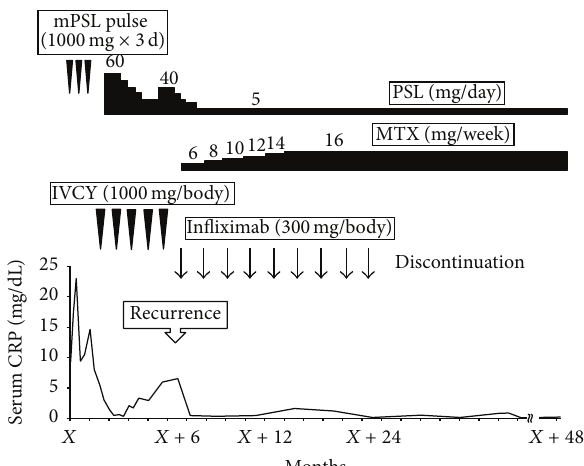
Figure 3: Patient’s clinical time course. mPSL methylprednisolone, PSL prednisolone, IVCY intravenous cyclophosphamide, and MTX